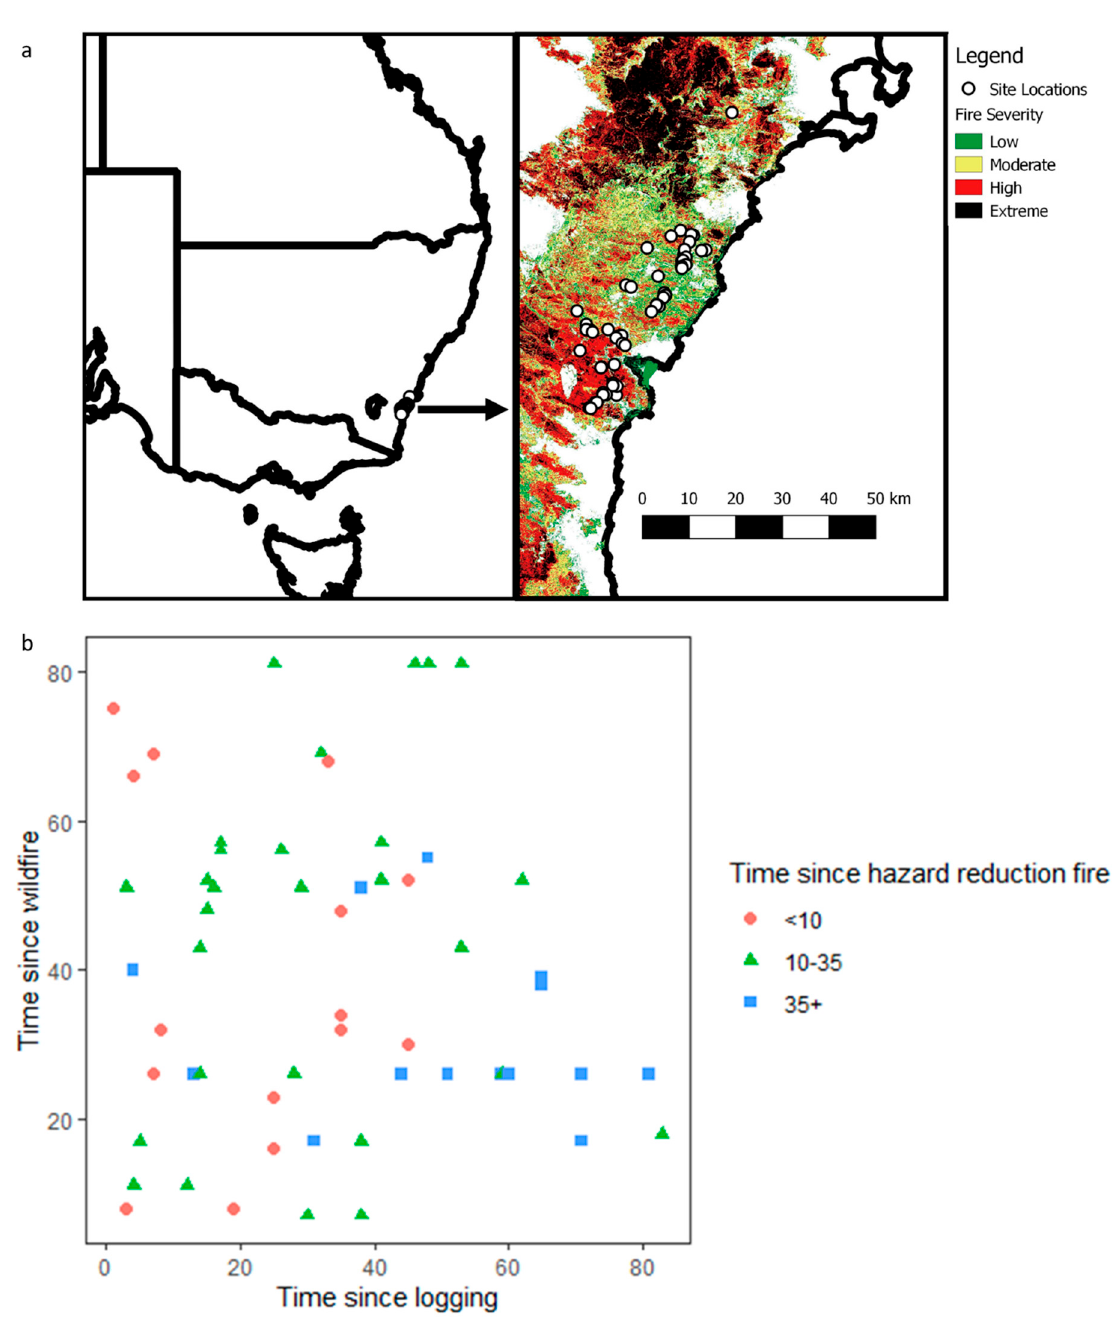
Figure 1. Location of the study area in south-eastern Australia (left), the individual plots within it and the severity of the 2019–2020 wildfires (right) ( a ). Severity mapping sourced from State Government of NSW Department of Planning‚ Industry and Environment [33]. Time since the last logging event, wildfire and hazard reduction fire prior to the 2019–2020 wildfires at the time of the post fire surveys for all 59 sites ( b ).